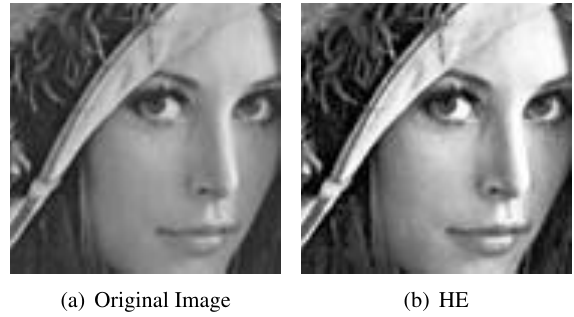
Fig. 4 Comparation between a gray-scale image of Lenna and the resulting image after having applied HE.